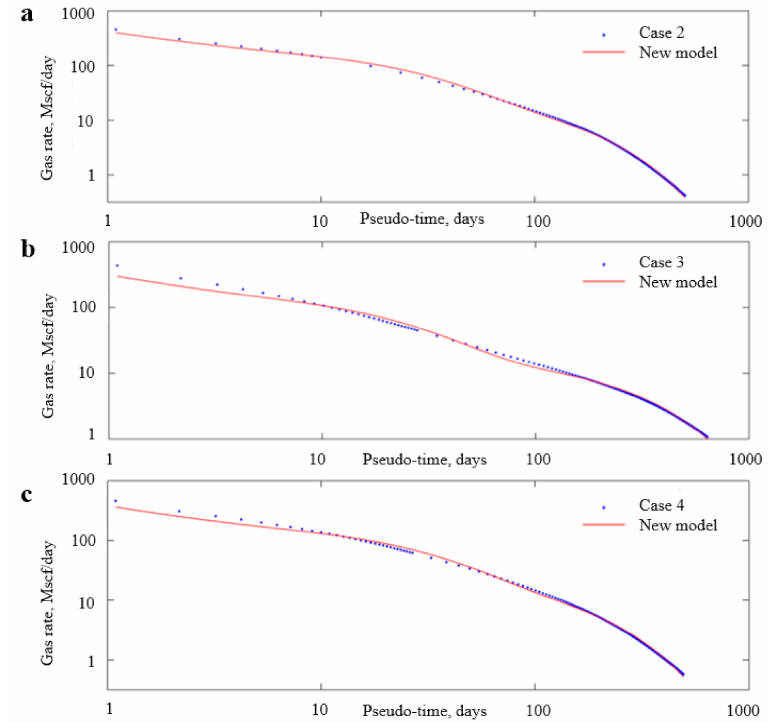
Figure 5. Comparison of the relationship of gas rate vs. pseudo-time from the numerical cases and new analytical solution. ( a ) Comparison of the relationship of gas rate vs. pseudo-time from the Case 2 and new model. ( b ) Comparison of the relationship of gas rate vs. pseudo-time from the Case 3 and new model. ( c ) Comparison of the relationship of gas rate vs. pseudo-time from the Case 4 and new